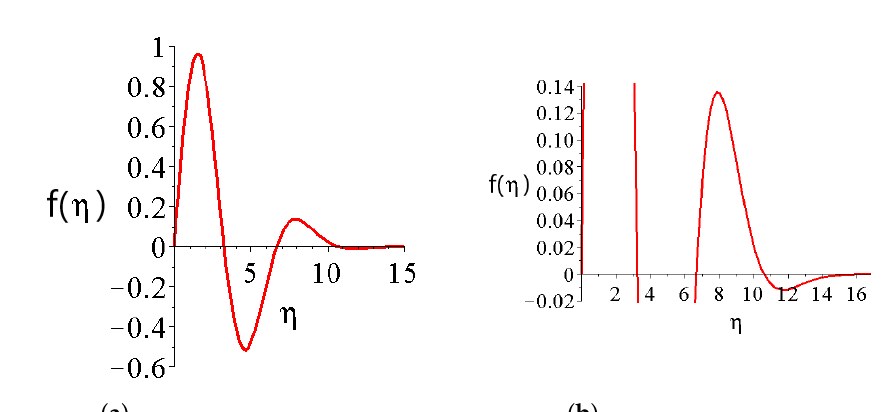
Figure 6. ( a ) Functions of Equation (45) for α = 1 when β = 1/8 , ( b ) magnification of f ( η ) for values close to